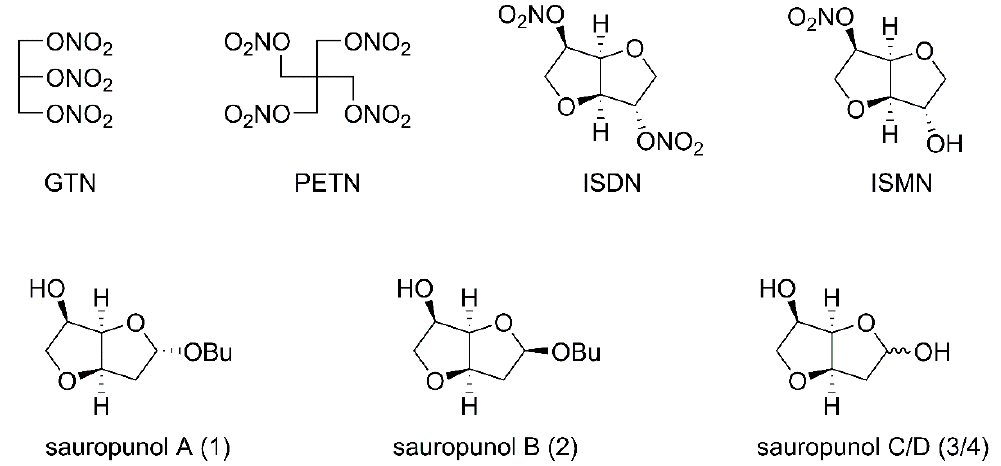
Figure 1. Structures of classical nitrate vasodilators and sauropunol A–D isolated from leaves of Sauropus rostratus .